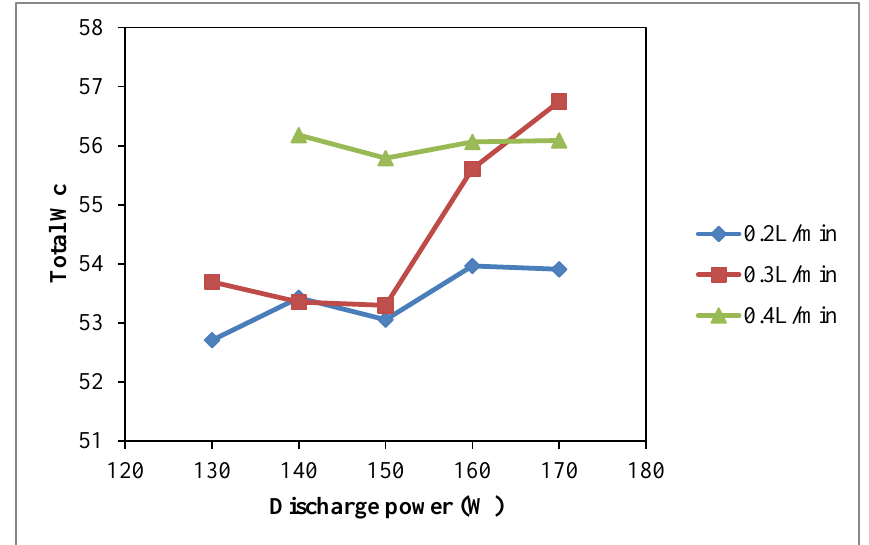
Figure 4. Effect of discharge power on total W c (Discharge power: 130 W, 140 W, 150 W, 160 W and 170 W; Oxygen flow rate: 0.2 L/min, 0.3 L/min and 0.4 L/min; Jet travelling speed: 5 mm/s and Jet-to-substrate distance: 3 mm).